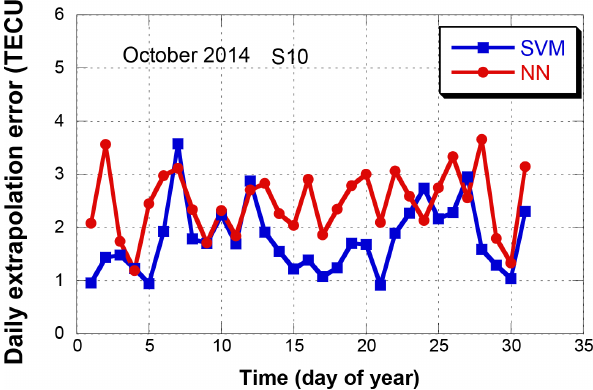
Figure 12. Daily extrapolation RMS error variations in October 2014 (south 10 ◦ point).